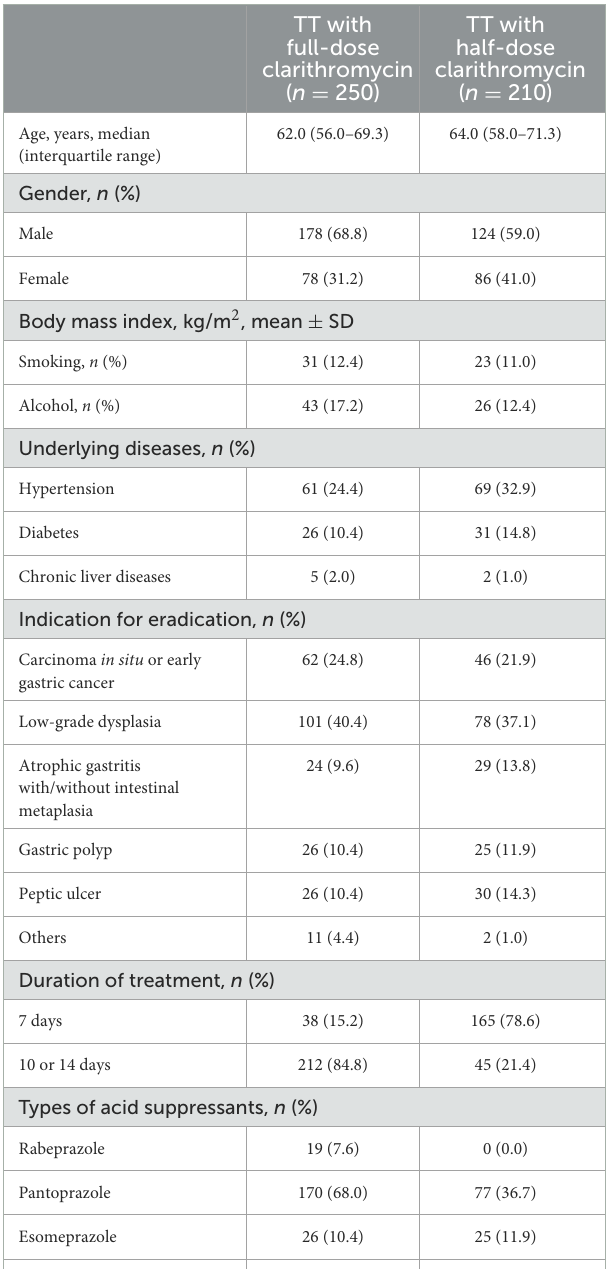
TABLE 1 Baseline demographic and clinical